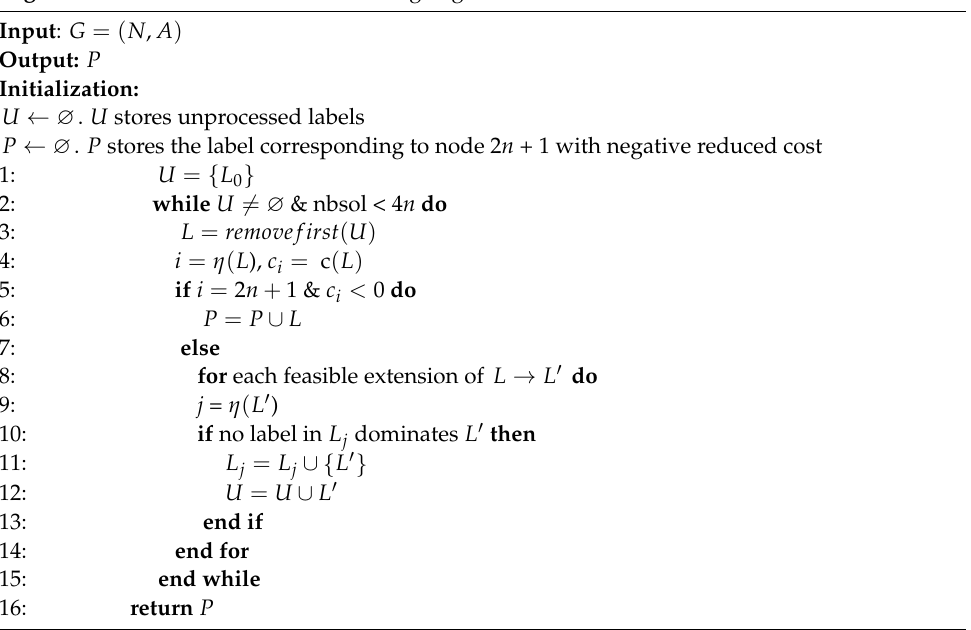
Algorithm 1 Pseudo-Code of Label Setting